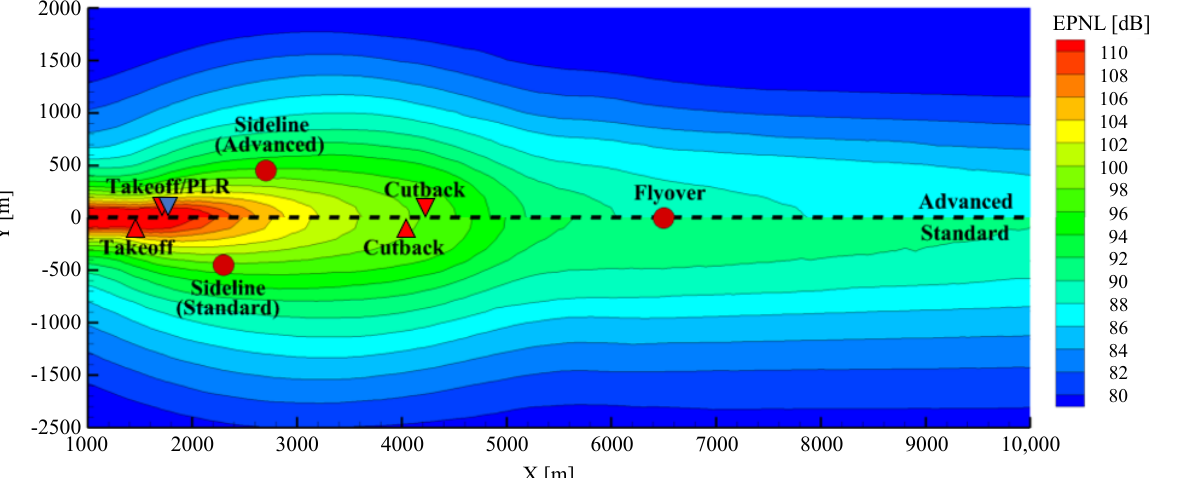
Figure 9. Comparison of EPNL contours for advanced ( top ) and standard procedure ( bottom ) of the aircraft TWO . Point of take-off, PLR and Cutback (triangles) as well as lateral and flyover reference noise measurement point (red dots) are marked with symbols. The x position is specified relative to the brake-release